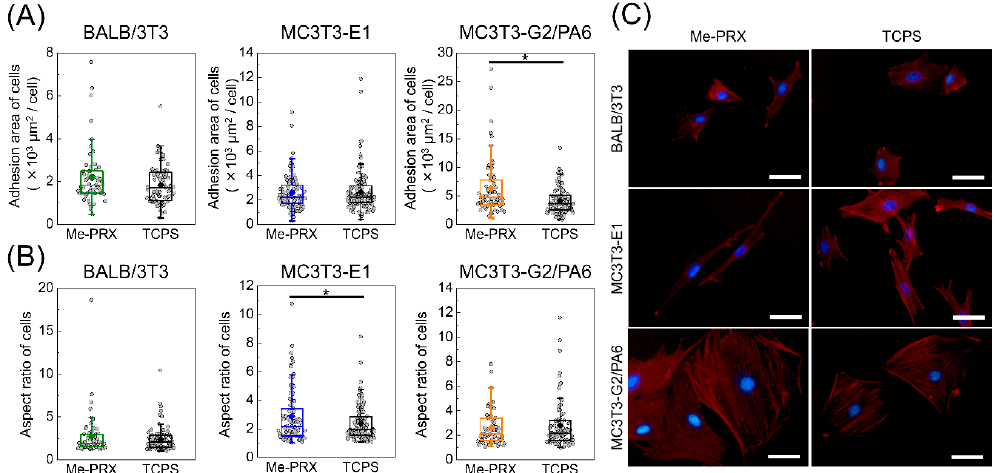
Figure 3. ( A ) The adhesion area of BALB/3T3, MC3T3-E1, and MC3T3-G2/PA6 cells on the surface of Me-PRX and tissue culture polystyrene (TCPS) surfaces. ( B ) Aspect ratio of cells on each surface. Each rectangle represents the mean. Data are presented as mean ± S.D., n ≥ 50. * p < 0.05 (Student’s t -test). ( C ) Fluorescent images of cells on each surface after 24 h culture. Blue, nucleus; red, actin filament. Scale bars, 50 μ m.